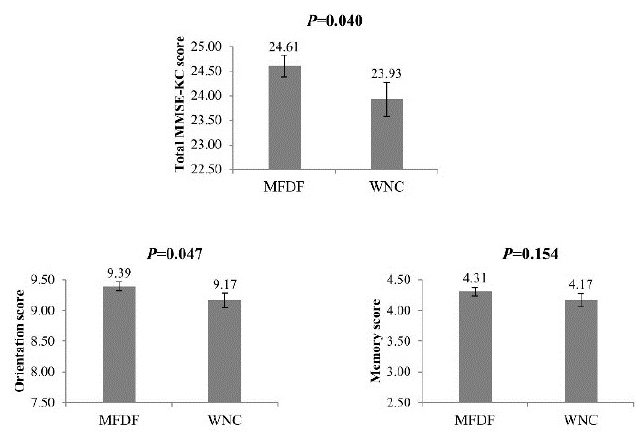
Figure 1. Means of the total MMSE-KC, orientation, and memory scores across the two dietary patterns. MFDF: Multigrain rice, Fish, Dairy products, and Fruits & fruit juices; WNC: White rice, Noodles, and Coffee. All dietary patterns were adjusted for sex, alcohol consumption, regular exercise, and